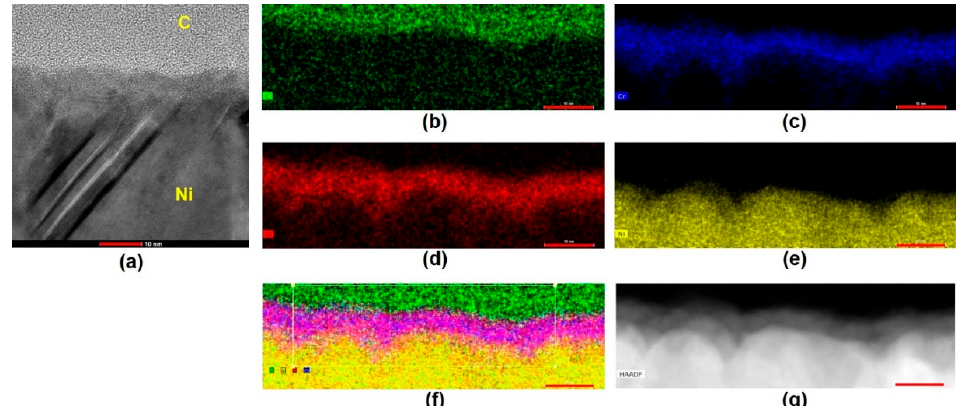
Figure A8. ( a ) High-resolution cross-sectional TEM image of the carbon film on a Ni film that was covered by a thin Cr film and grown on a silicon wafer, showing a homogenous amorphous carbon film without any nanolayered structures on the interface or anywhere else; ( b ) color-coded EDS elemental map of carbon ( c ) in the interface region, where the green color represents the C K-alpha x-ray signal); ( c ) color-coded EDS elemental map of Cr (blue); ( d ) color-coded EDS elemental map of O (red), which overlaps with the Cr in ( c ), indicating that the Cr layer was oxidized; ( e ) color-coded EDS elemental map of Ni (yellow); ( f ) color-coded EDS elemental map of C, Cr, O, Ni combined together; ( g ) HAADF STEM micrograph of the same region mapped in ( f ). Scale bar in ( a – g ): 10 nm.